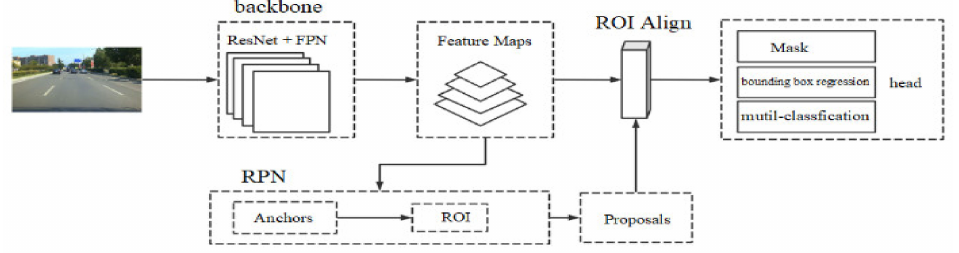
Figure 1. Mask R-CNN network framework.